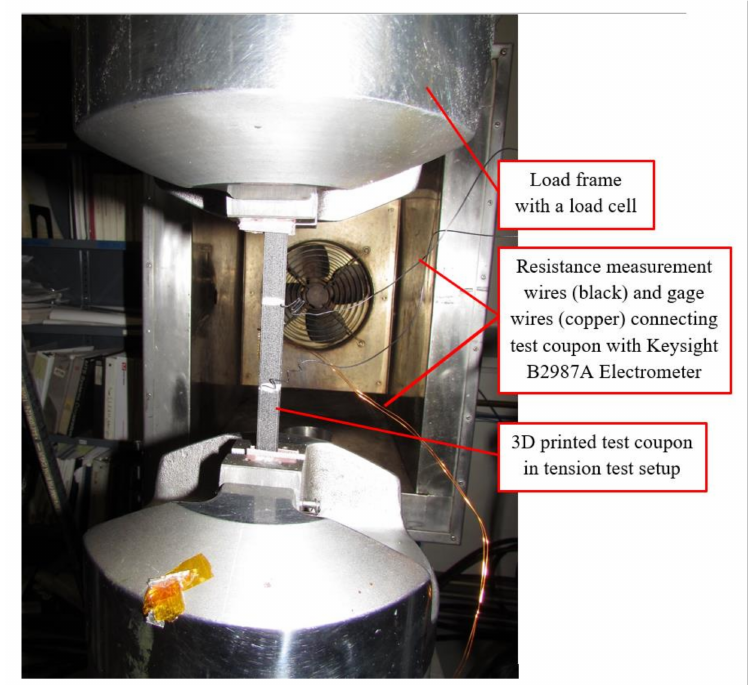
Figure 5. Coupled electro-tensile test set up at